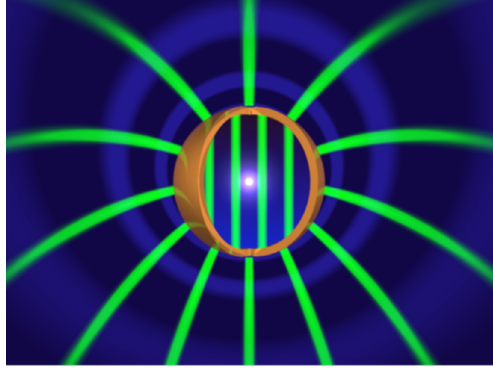
Figure 1. Shell-charge system in a uniform gravitational field. This figure is an artistic representation of the effect of gravity on the electric fields of the shell. The electric field lines of the charged shell are shown in green, and equipotential lines are indicated in blue. The field inside the shell is much weaker than the field on the outside. The field lines on the inside convey the fact that, due to the presence of a uniform gravitational field, a uniform, vertical electric field is induced inside the shell [12]. Outside of the shell, the field lines droop downward. An electron (central white spot) is placed in the uniformly- and positively-charged shell (copper-colored sphere). At a shell voltage of about 1 MV, the electron will experience an upward, gravitationally-induced electric force that is balanced by its gravitational